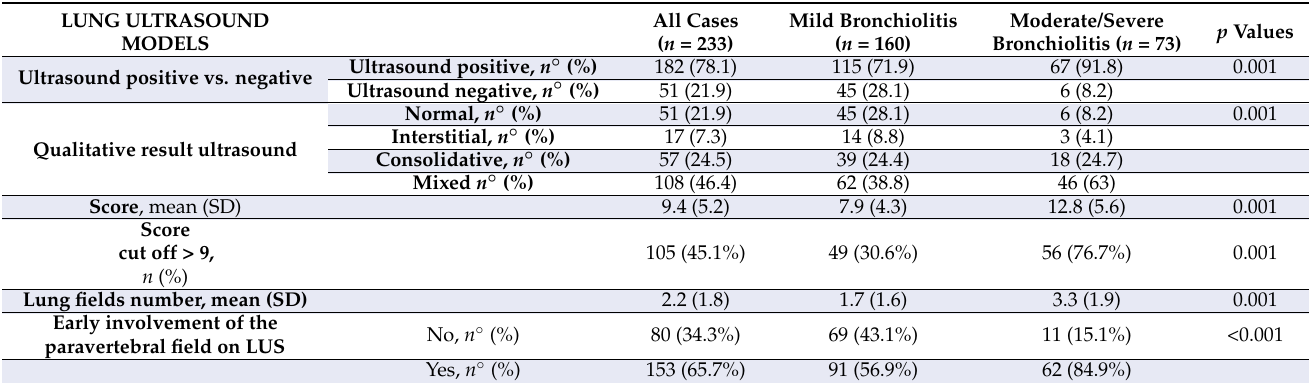
Table 3. Results at the baseline lung ultrasound. Comparison of LUS findings between patients with moderate/severe and mild